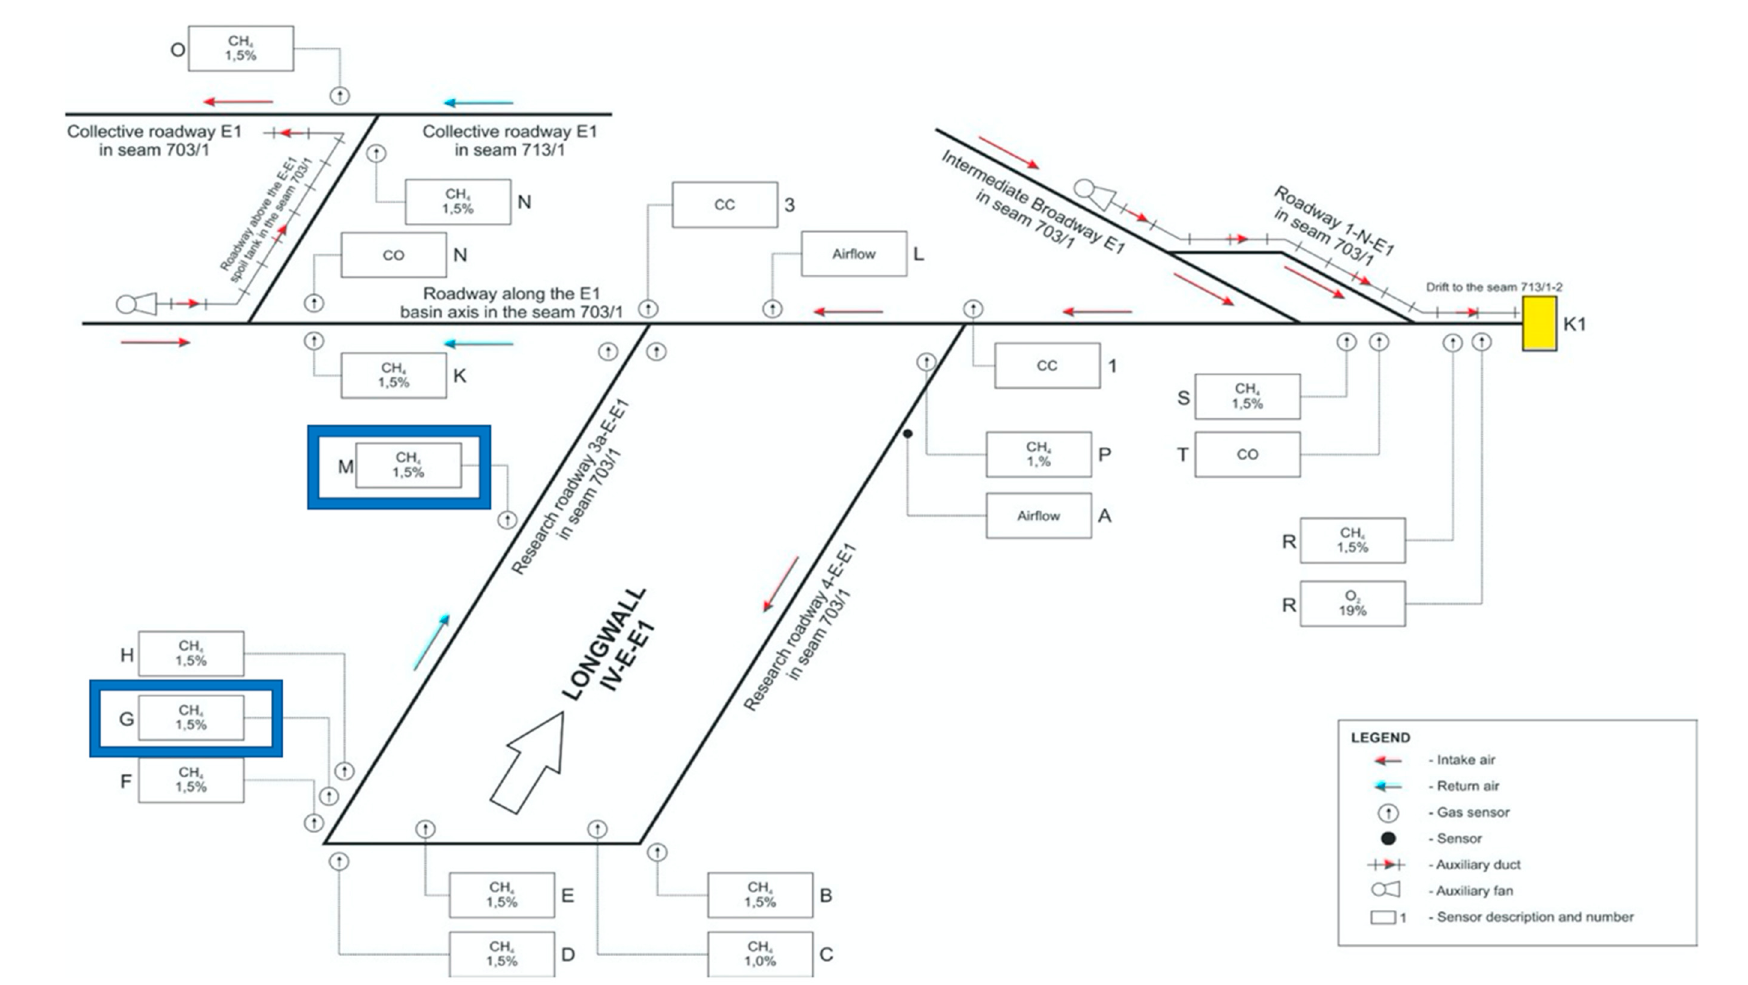
Figure 4. The arrangement of the sensors of the methanometric system in longwall IV seam 703/.